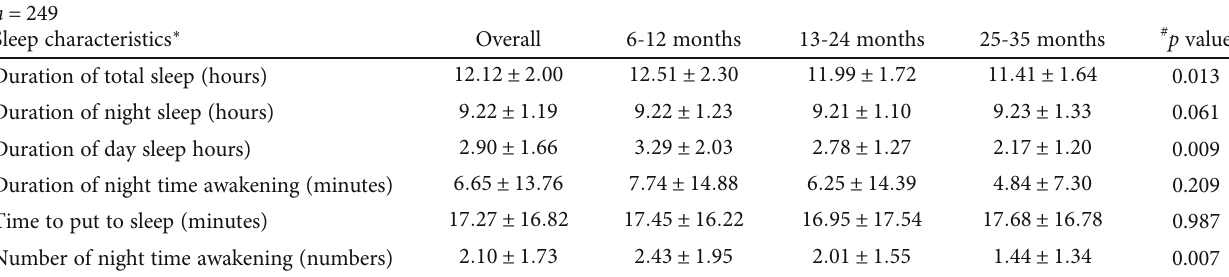
Table 3: Sleep characteristics according to age group.